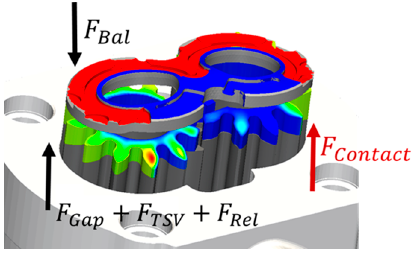
Figure 6. Figure representing the system of forces acting on the lateral bushing.